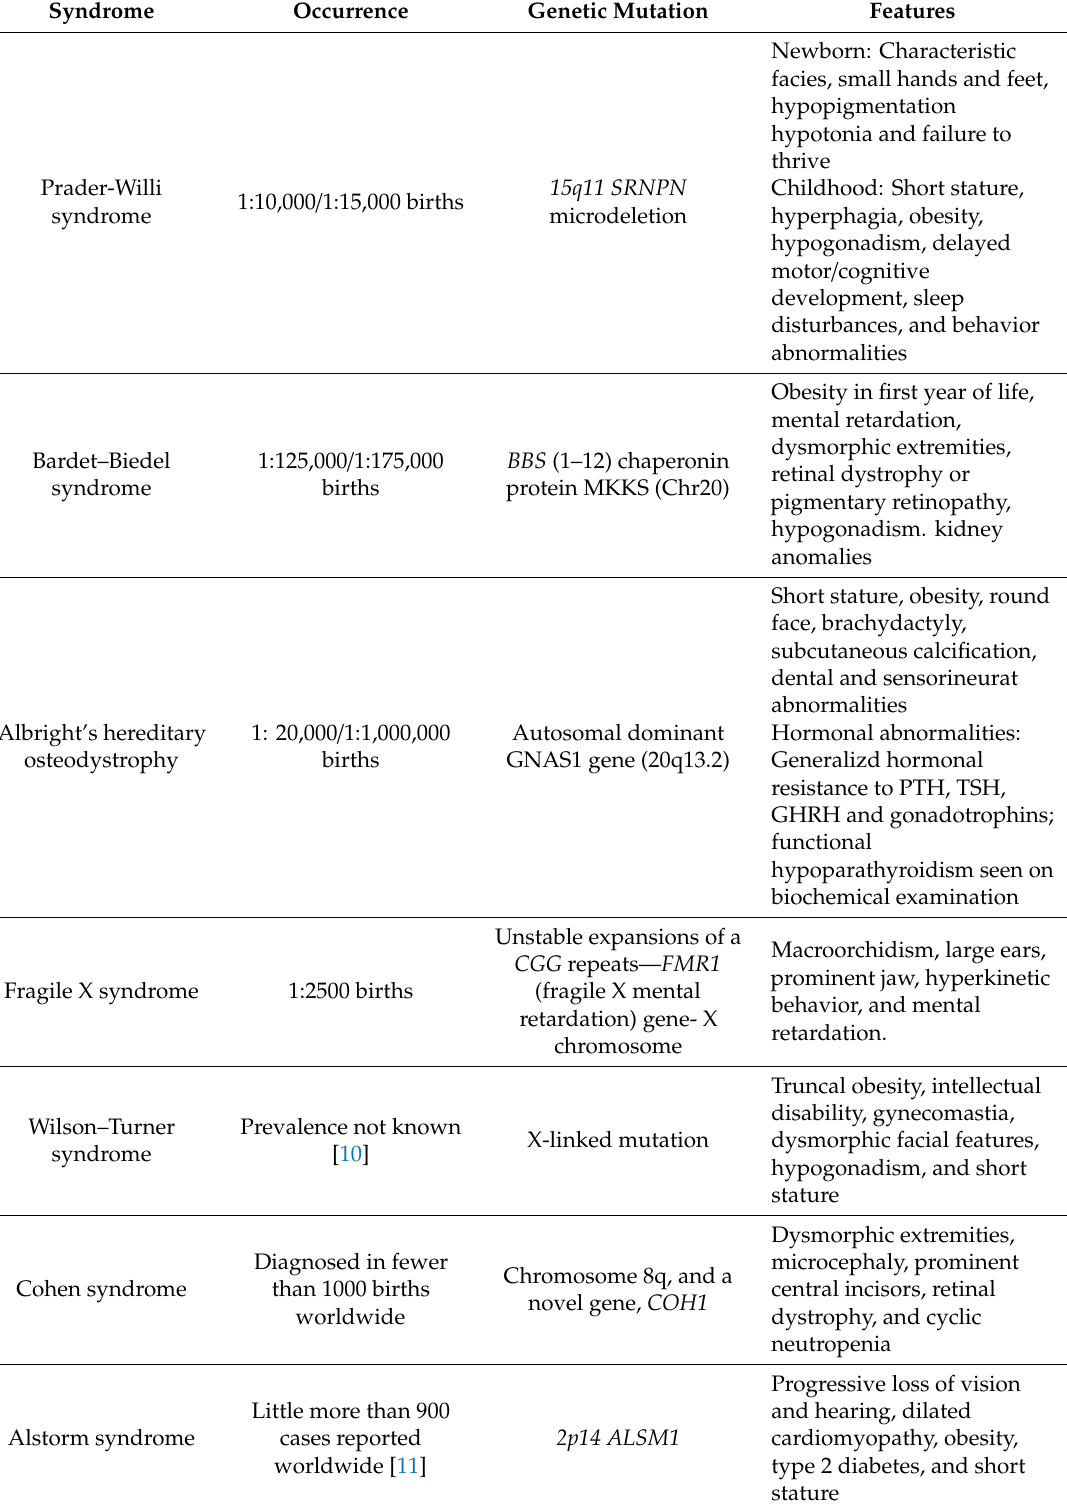
Table 1. Syndromic obesity